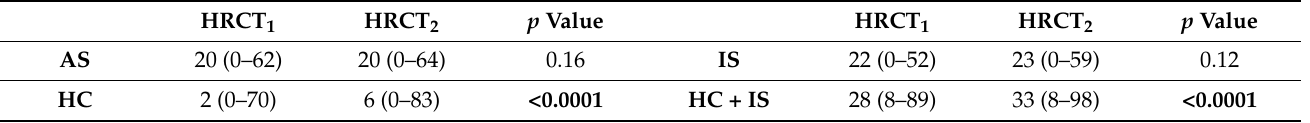
Table 1. Radiological scores at treatment initiation (HRCT1) and after one year of treatment (HRCT2) in the entire study